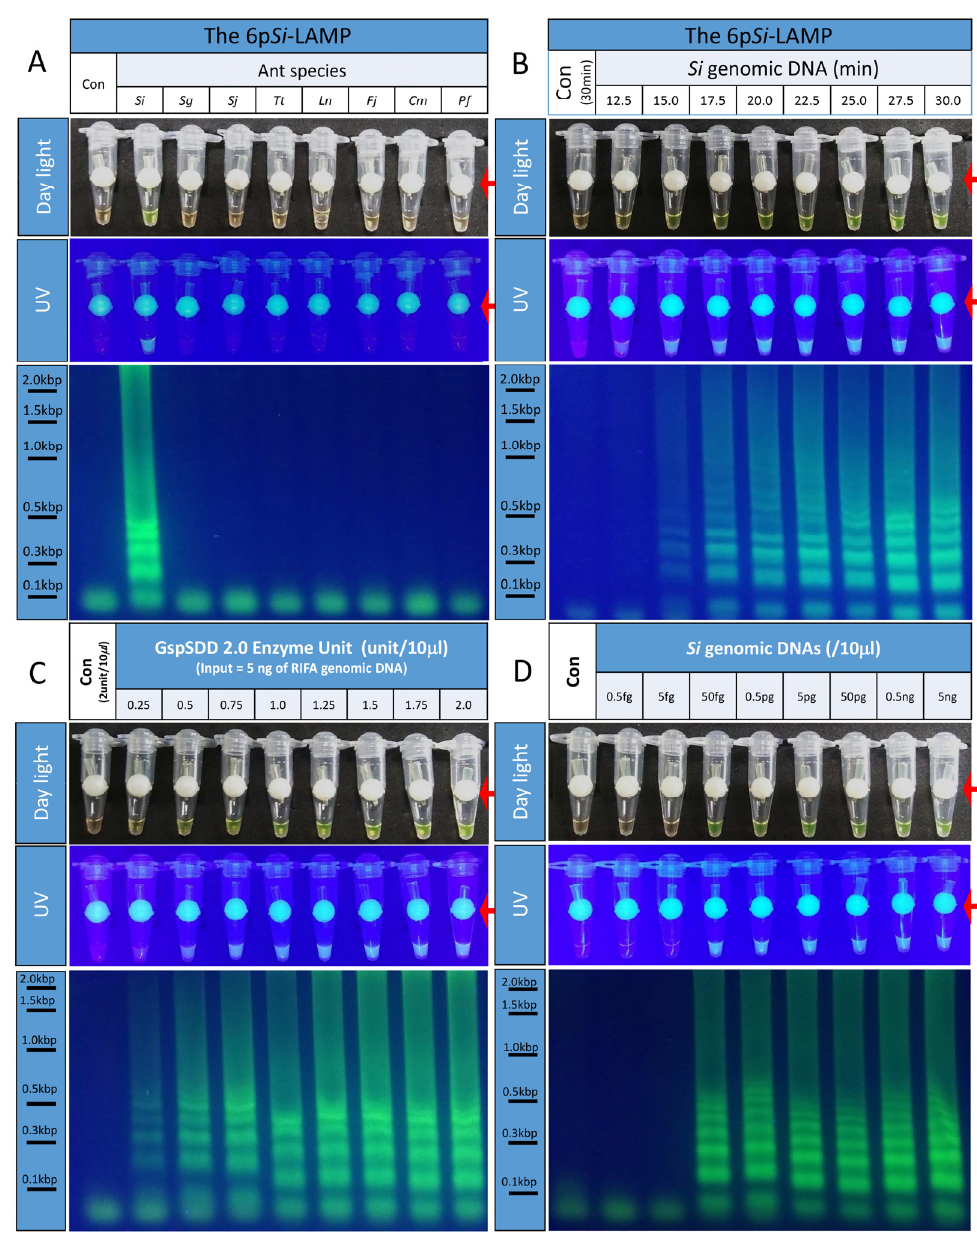
Figure 2. Identification of optimal conditions for 6p Si -LAMP assays. ( A ) When 6p Si -LAMP assays were performed, strong fluorescence signals under daylight or UV light were detected only from a Si genomic DNA-containing tube. In addition, LAMP-specific ladder-shaped DNA bands were only detected from a Si genomic DNA-containing tube. ( B ) To determine the optimum incubation period for the 6p Si -LAMP assay, LAMP mixtures containing 5 ng of Si genomic DNA were incubated at 65°C for 12.5 to 30 min at 2.5-min intervals. Fluorescence signals under daylight or UV illumination were detected after 12.5 min. When the reactions were separated by a 1.5% agarose gel, ladder-shaped DNA bands were detected from tubes incubated longer than 15 min. ( C ) To determine optimal amounts of GspSDD 2.0 DNA polymerases for the 6p Si -LAMP assay, various amounts of polymerases were added. Weak or strong fluorescence and ladder-shaped bands began to be detected at 0.25 unit/10 μ L or 1.0 unit/10 μ L, respectively. ( D ) To determine the detection limits of the 6p Si -LAMP assay, various amounts of Si genomic DNA were used for 6p Si -LAMP assays. Strong fluorescence signals and ladder-shaped DNA bands were detected at concentrations 50 fg/10 μ L and above. Red arrows indicate locations of the fluorescence dye-delivering device inside tubes.